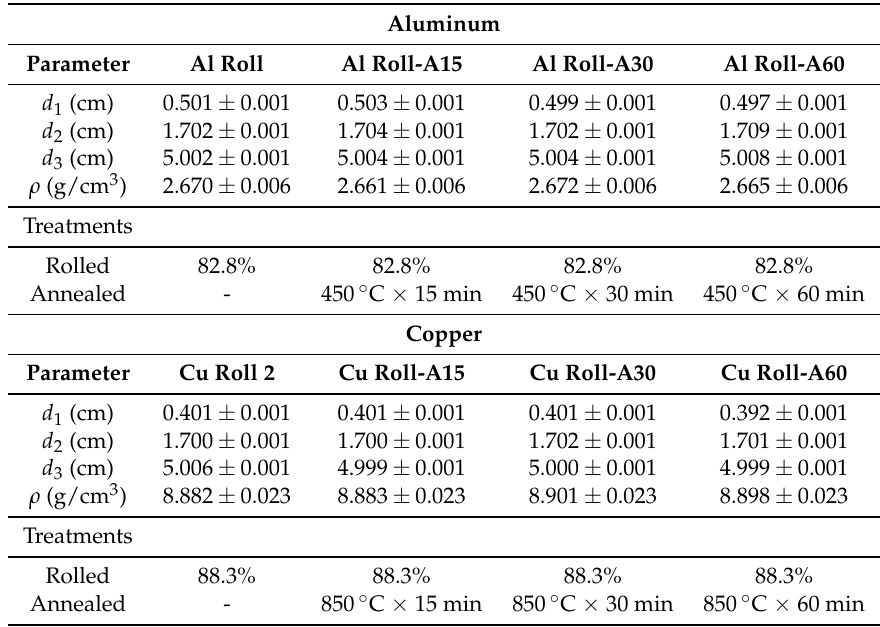
Table 1. Aluminum and Copper group characteristics: rectangular parallelepiped dimensions, mass density and treatments for the four samples of each group. Columns are ordered for decreasing expected dislocation